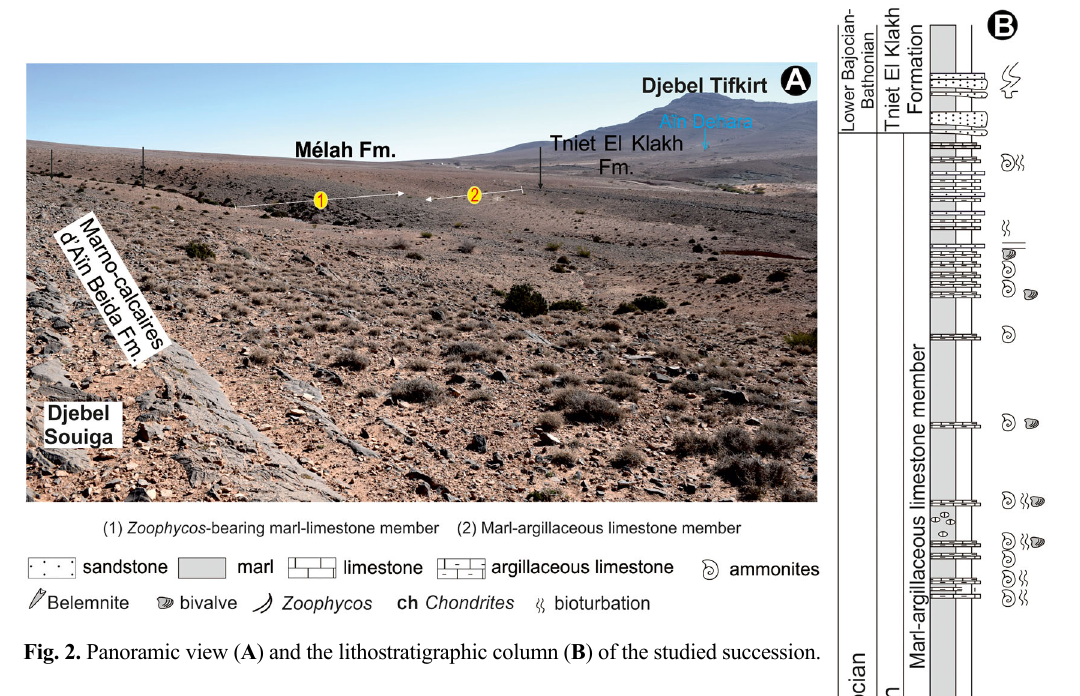
Fig. 2. Panoramic view ( A ) and the lithostratigraphic column ( B ) of the studied